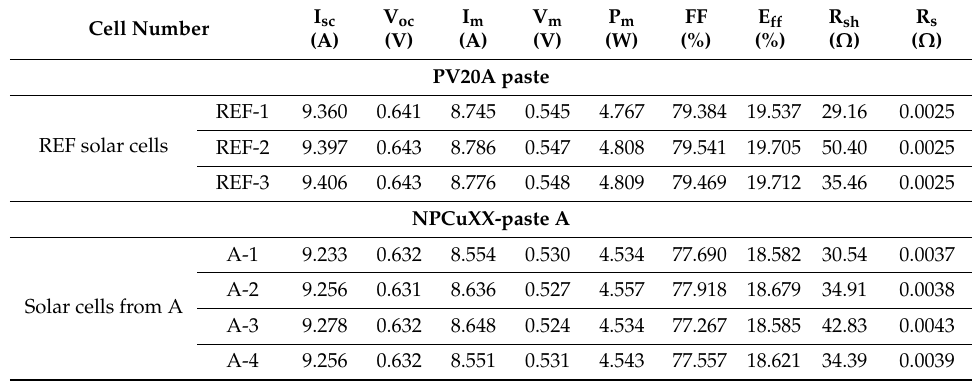
Table 3. The current-voltage (I-V) parameters of the 244 cm 2 , Cz-Si, Al-BSF solar cells area of 244 cm 2 fabricated by a screen-printing technique and co-fired at 940 ◦ C.